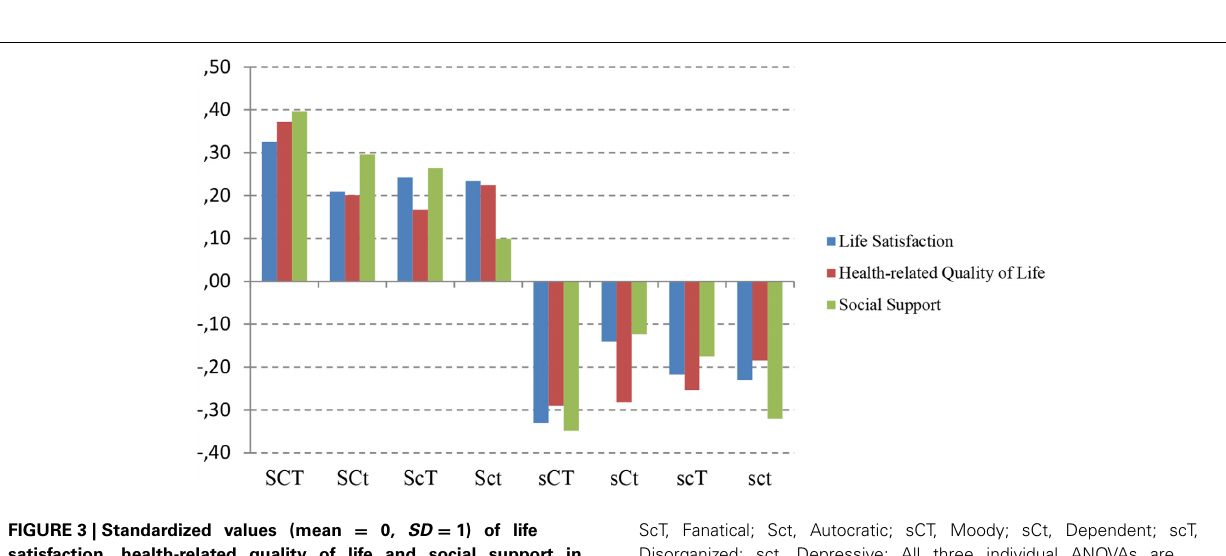
FIGURE 3 | Standardized values (mean = 0, SD = 1) of life satisfaction, health-related quality of life and social support in different character combinations. SCT, creative; SCt, Organized;